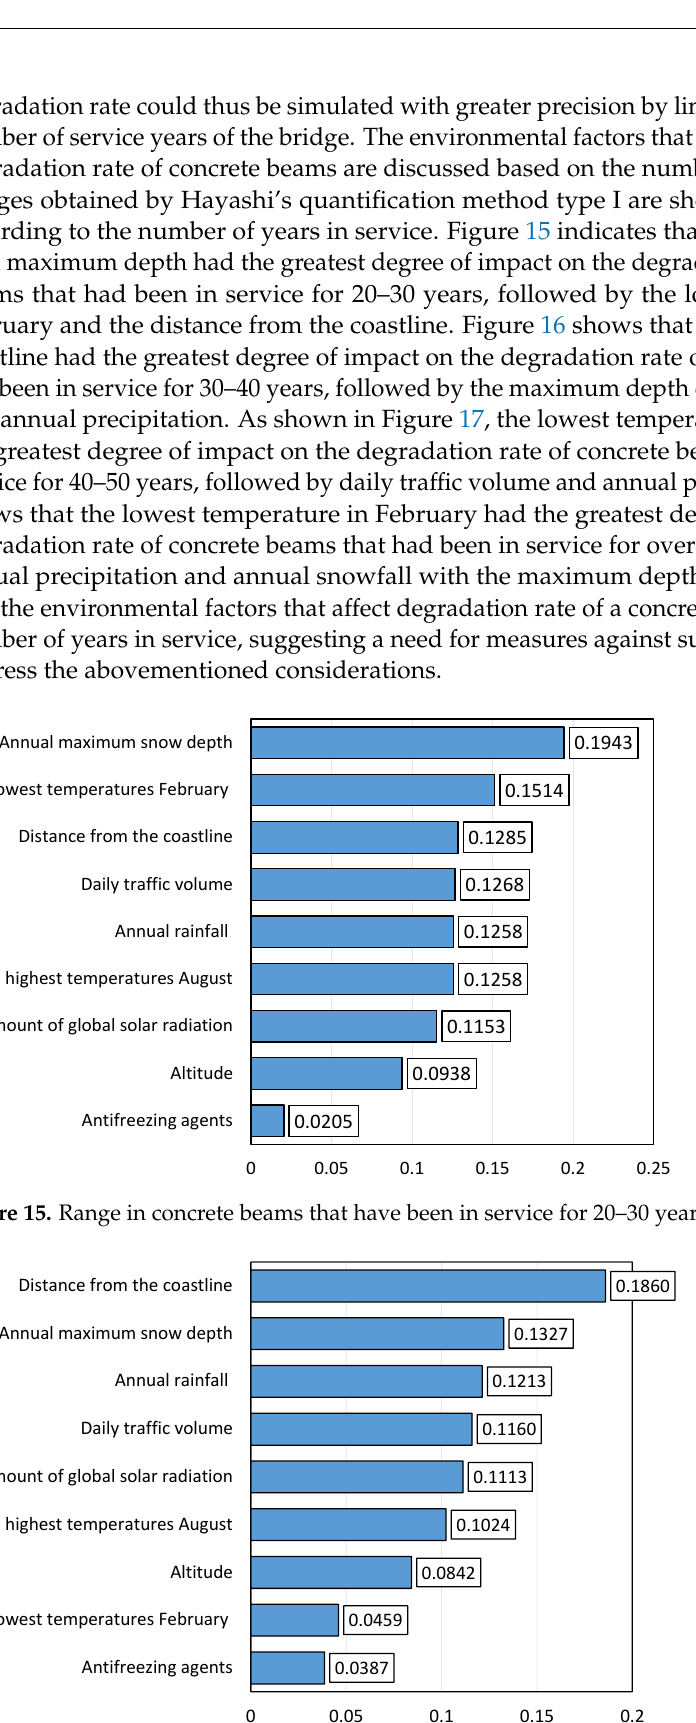
Figure 17. Range in concrete beams that have been in service for 40 – 50 years.